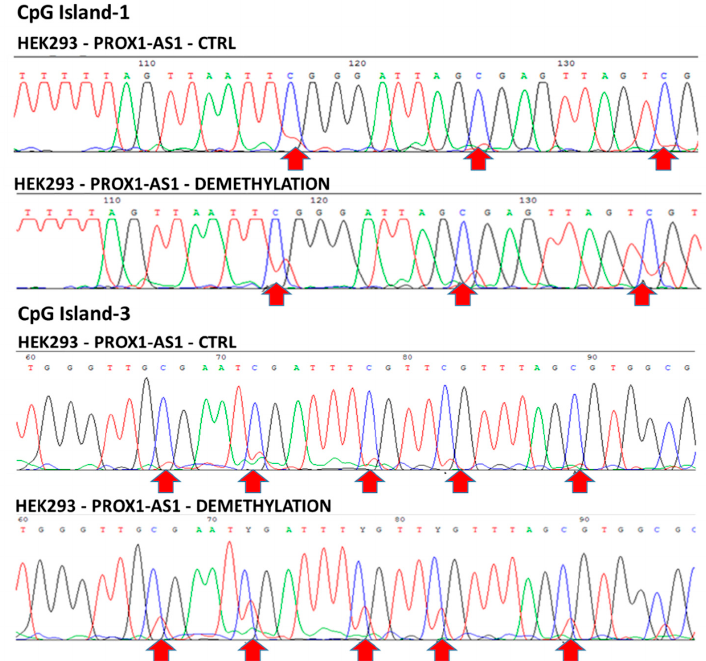
Figure 5. CpG-islands 1 and 3 methylation in HEK293 before and after 5-aza-2 ′ -deoxycytidine treatment. CpG island 1 and CpG island 3 before (top line) and after (bottom line) HEK293 treatment with 5-aza-2 ′ -deoxycytidine. Arrows indicate the location of the demethylated cytosines after the treatment with the demethylating agent (the appearance of red peaks in the bottom line corresponds to cytosine demethylation).